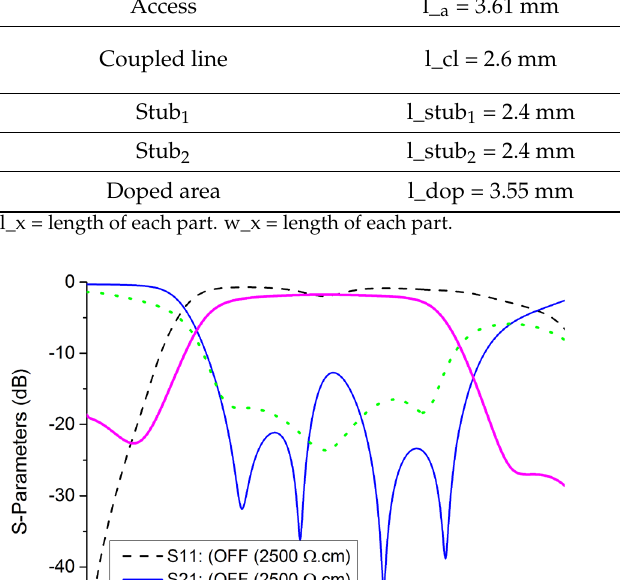
Figure 15. The 3D design of the 10 GHz reconfigurable filter.